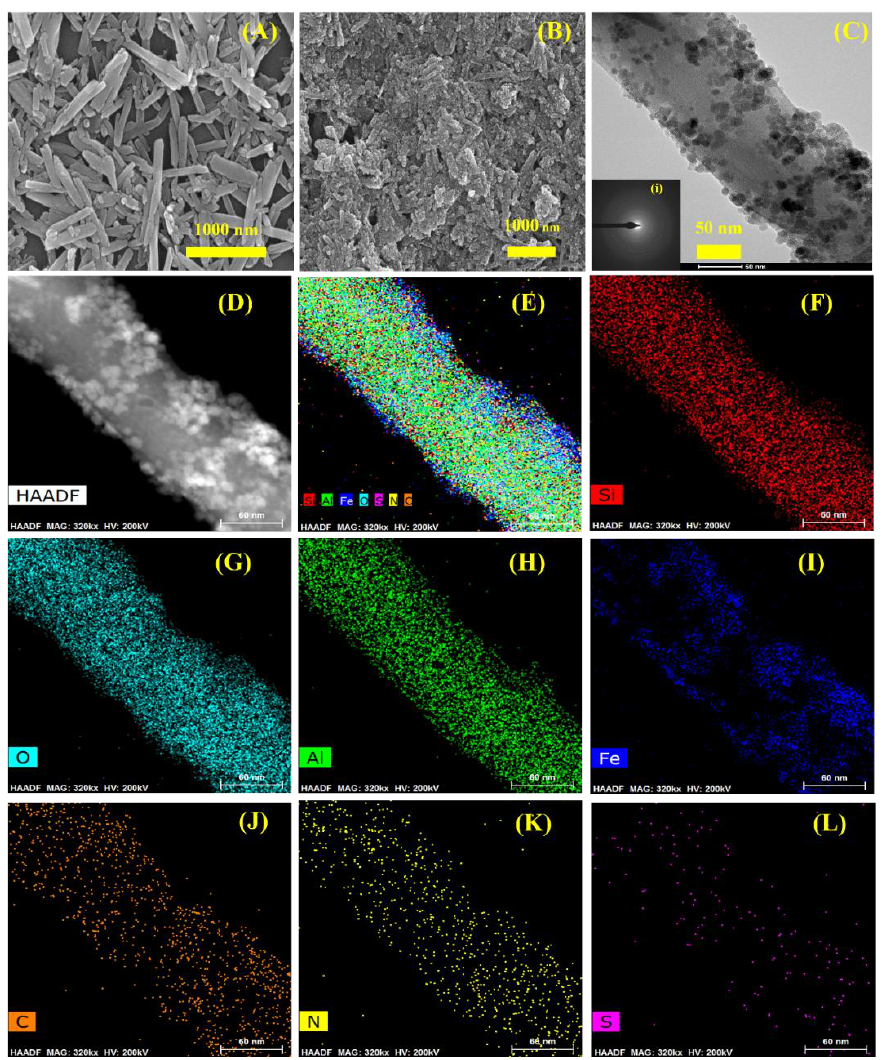
Figure 2. SEM analysis of ( A ) HNTs, and ( B ) HNTs-Fe 3 O 4 -CTs-SH. HR-TEM analysis of the HNTs-Fe 3 O 4 -CTs-SH ( C ) inset (i) SAED pattern of the HNTs-Fe 3 O 4 -CTs-SH. The STEM HAADF image of HNTs-Fe 3 O 4 -CTs-SH ( D ), elemental mapping of HNTs-Fe 3 O 4 -CTs-SH ( E ), and corresponding elemental distribution of Si ( F ), O ( G ), Al ( H ), Fe ( I ), C ( J ), N ( K ) and S ( L ).